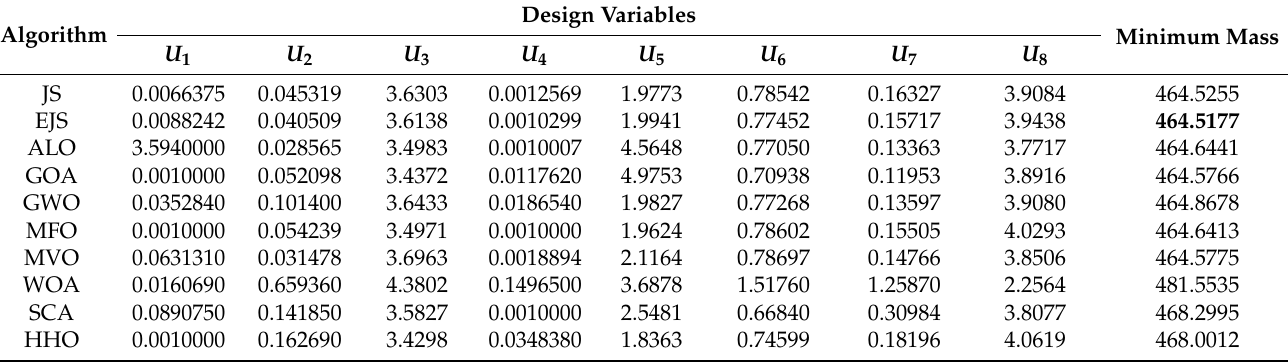
Table 11. Evaluation indicators and the variable values for Figure 13.